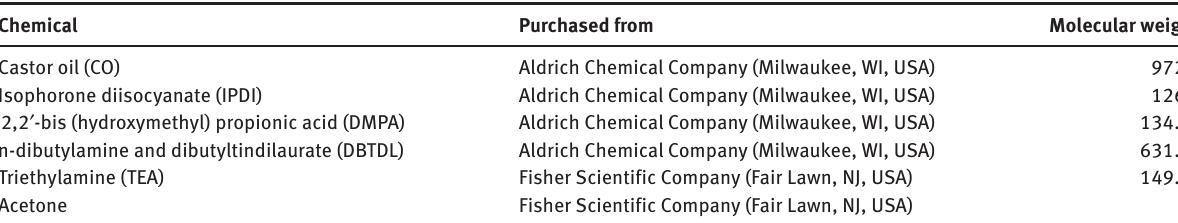
Table 1: Chemical used for synthesis and procured along with their molecular weight. Chemical Purchased from Castor oil